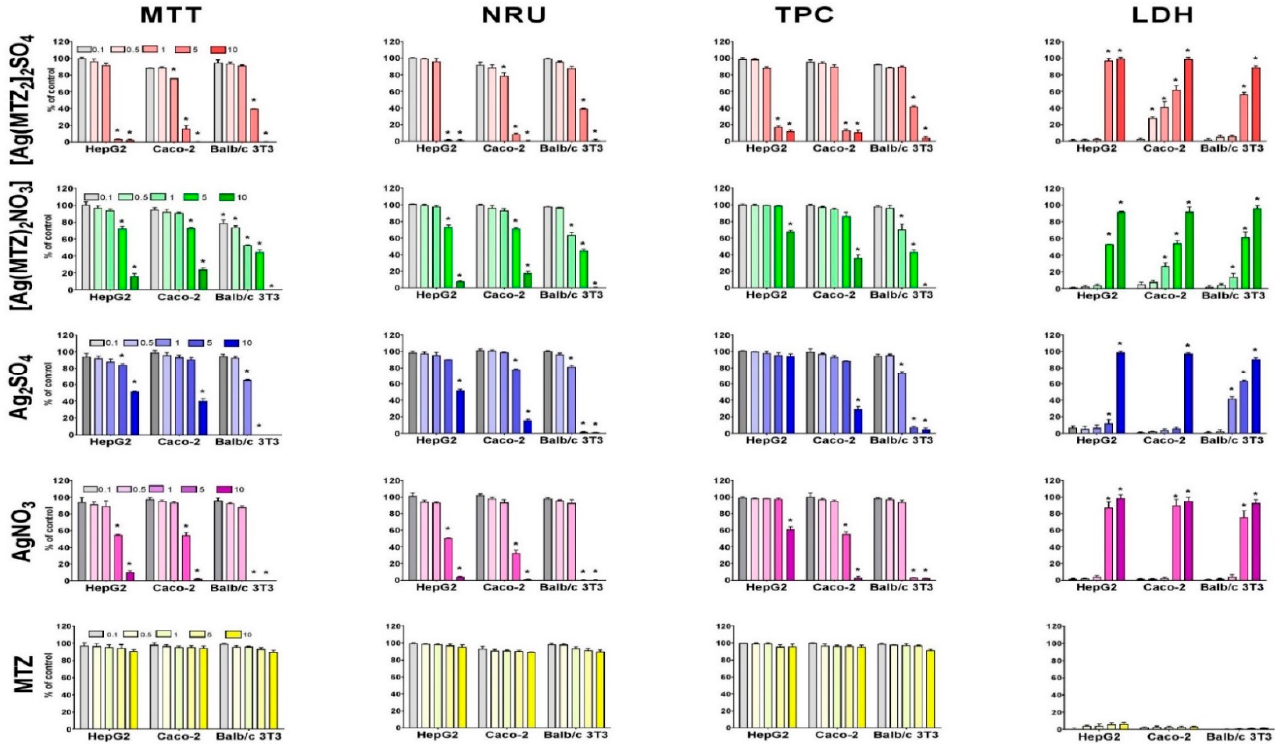
Figure 6. Concentration- and cell model-dependent decrease in viability after exposure for 72 h to studied compounds and metronidazole assessed by MTT, NRU, TPC and LDH assays. The results are expressed as mean ± SD of three independent experiments. * p ≤ 0.05 in comparison with control.